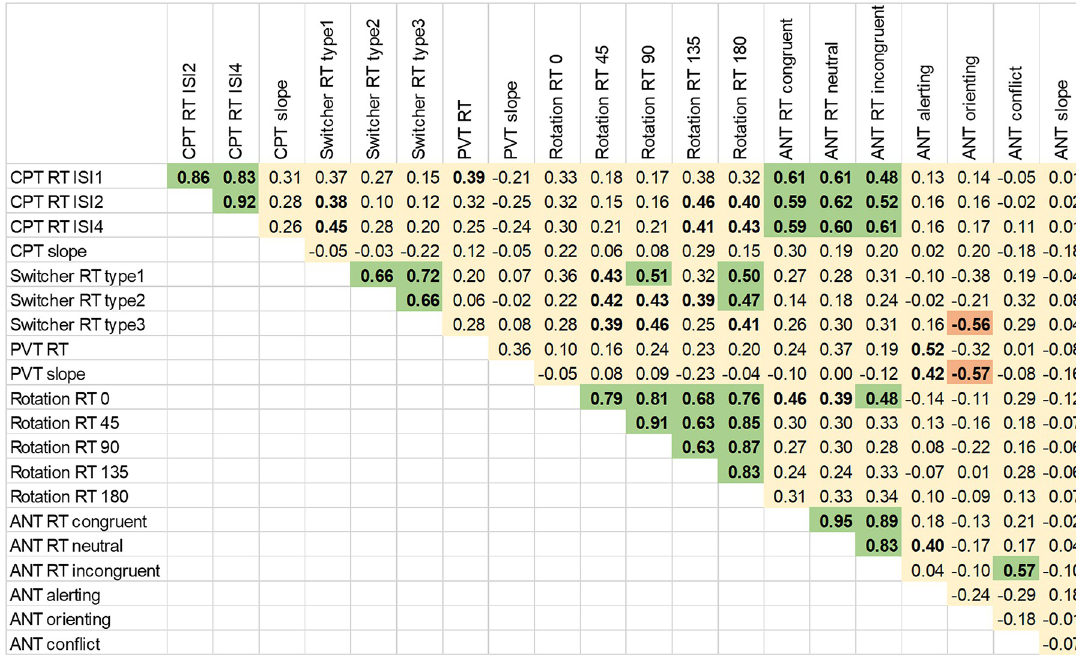
Fig 5. Correlation among scores from the tasks on the first day of application. Significant positive and negative correlations (FDR- corr. p < 0.05) are reported in green and red, respectively. Correlations with p < 0.05, uncorrected for multiple comparisons, are shown in bold. CPT = Continuous Performance Task; PVT = Psychomotor Vigilance Task; ANT = Attention Network Test; RT = reaction time; ISI1, ISI2, ISI4 = inter-stimulus interval of 1, 2, and 4 s, respectively; type1, type2, type3 = alternate switch, fixed switch, random switch,